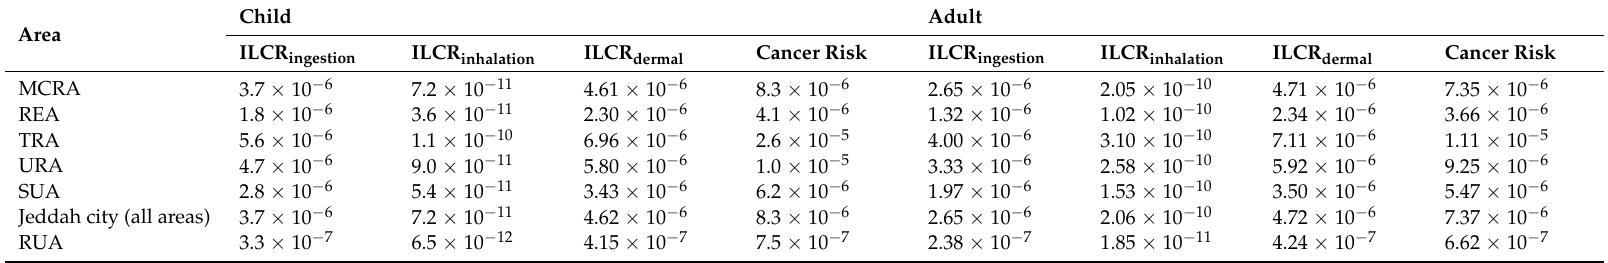
Table 4. Incremental lifetime cancer risks and cancer risks of the total PAH compounds for children and adults population living in different areas of Jeddah city and a rural area (RUA) of Hada Al